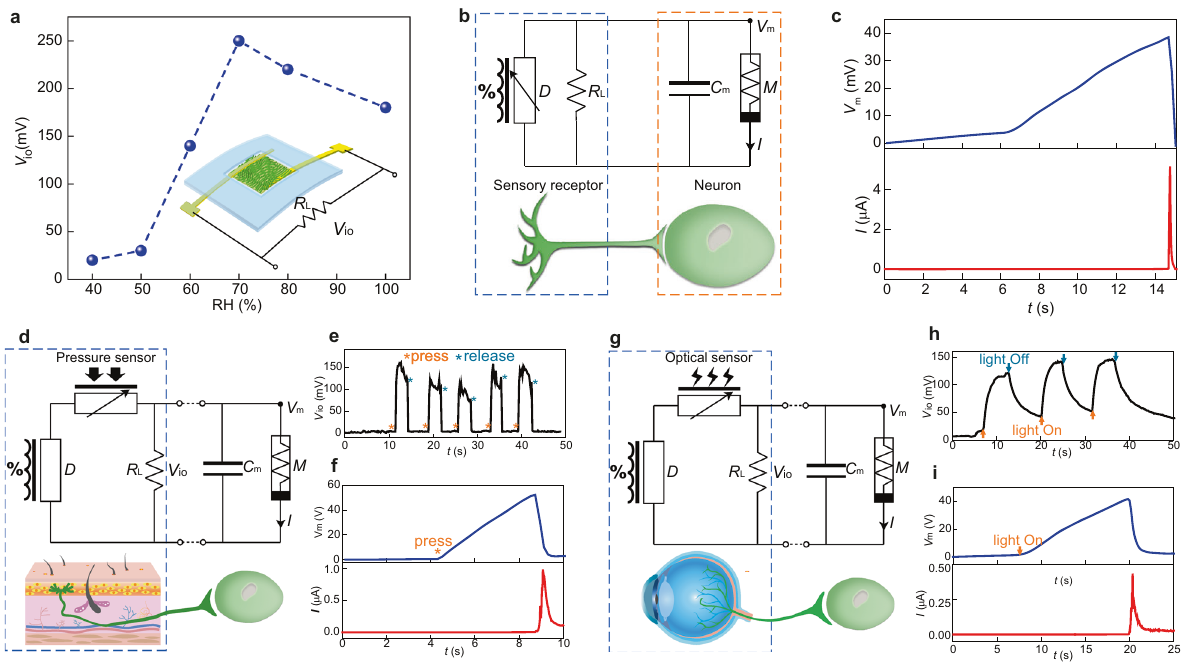
Fig. 2 Multifunctional sensory neuromorphic interfaces. a Voltage output ( V io ) from a vertical protein nanowire sensor connected with a load resistor ( R L ) measured at different RH. b Circuit diagram of feeding V io from the protein nanowire sensor ( D ) into an arti fi cial neuron made from a protein nanowire memristor ( M ) and a capacitor ( C m ) by emulating an afferent circuit (bottom). c Evolution in the membrane potential ( V m ) and current ( I ) in the arti fi cial neuron when placed the sensor on a sweating skin. d Circuit diagram of feeding V io from a tactile sensory component (made from a protein nanowire device ( D ) and a resistive pressure sensor) into an arti fi cial neuron by emulating a tactile afferent circuit (bottom). e Touch-induced V io from the tactile sensory component. f Evolution in the membrane potential ( V m ) and current ( I ) in the arti fi cial neuron by pressing the pressure sensor. g Circuit diagram of feeding V io from an optical sensory component (made from a protein nanowire device ( D ) and an optical sensor) into an arti fi cial neuron by emulating an optical afferent circuit (bottom). h Light-induced V io from the optical sensory component. i Evolution in the membrane potential ( V m ) and current ( I ) in the arti fi cial neuron by lighting the optical